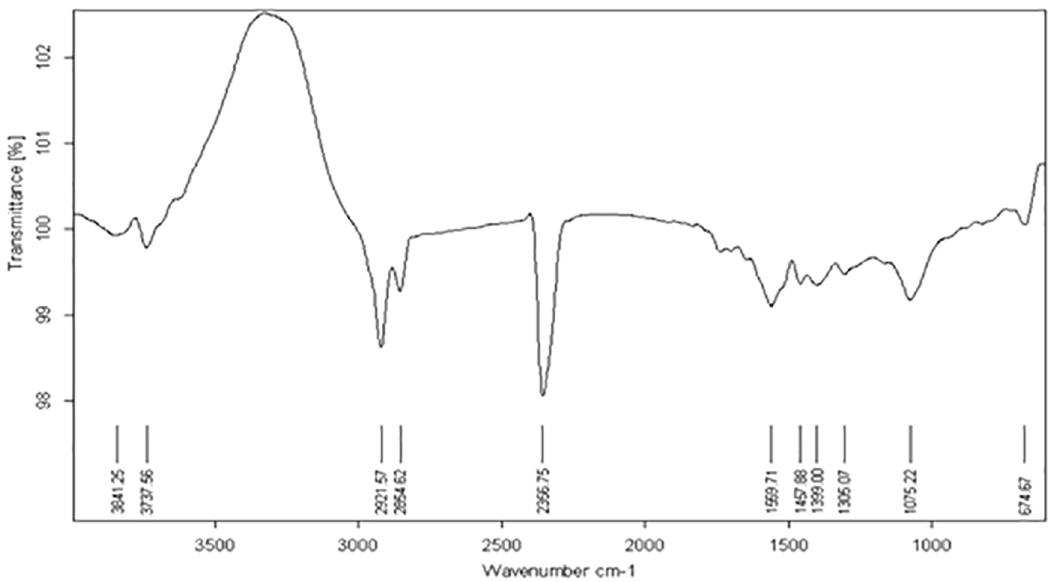
Figure 4: FT - IR spectrum of walnut leaf